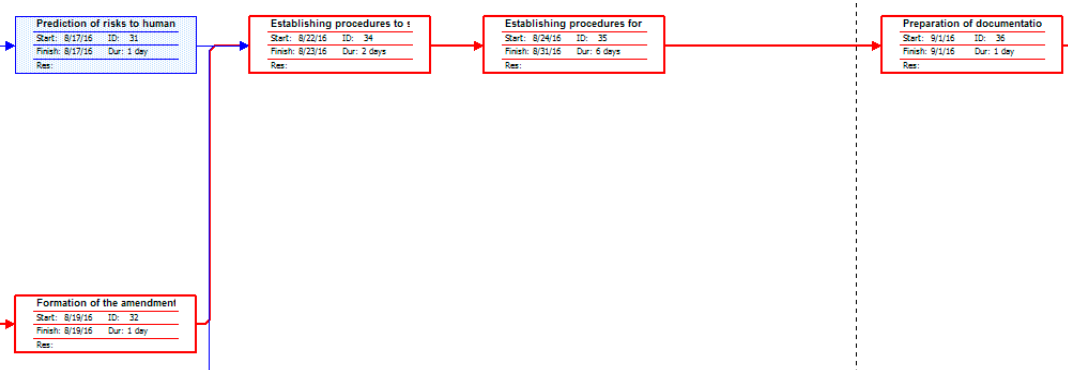
Figure 10. Illustrative part of network diagram of the final phase of the project to improve the environmental protection system in mining and energy complexes.